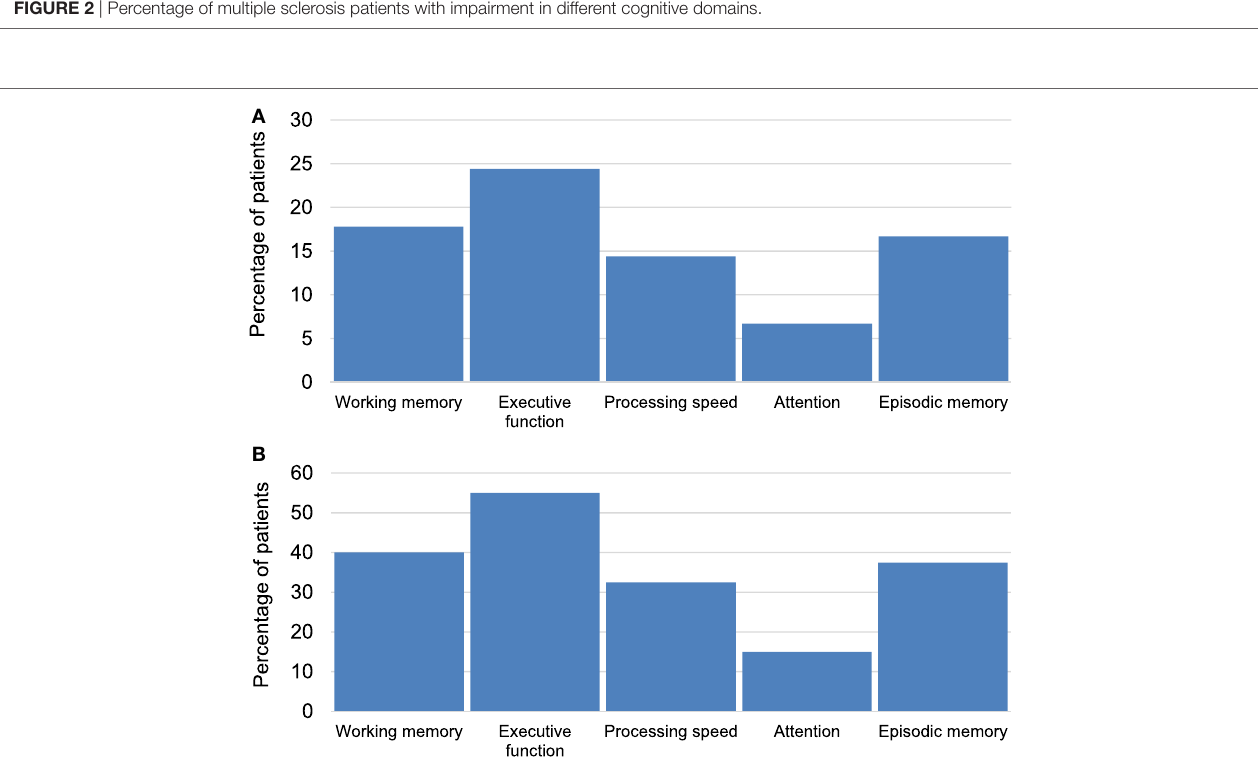
FigUre 2 | Percentage of multiple sclerosis patients with impairment in different cognitive